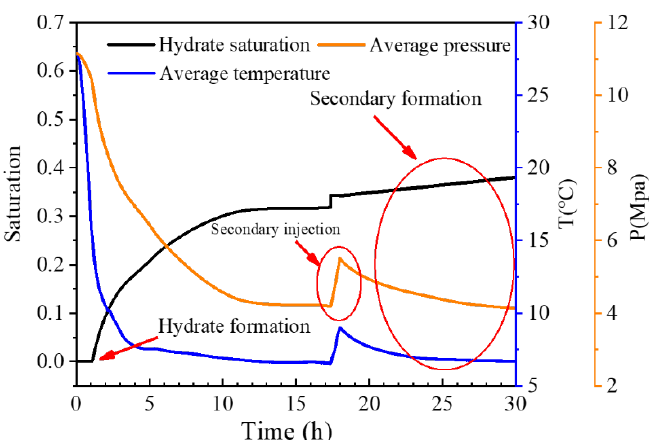
Figure 9. Variation in average temperature and pressure in the reactor and hydrate saturation derived at 30 h into the synthesis.